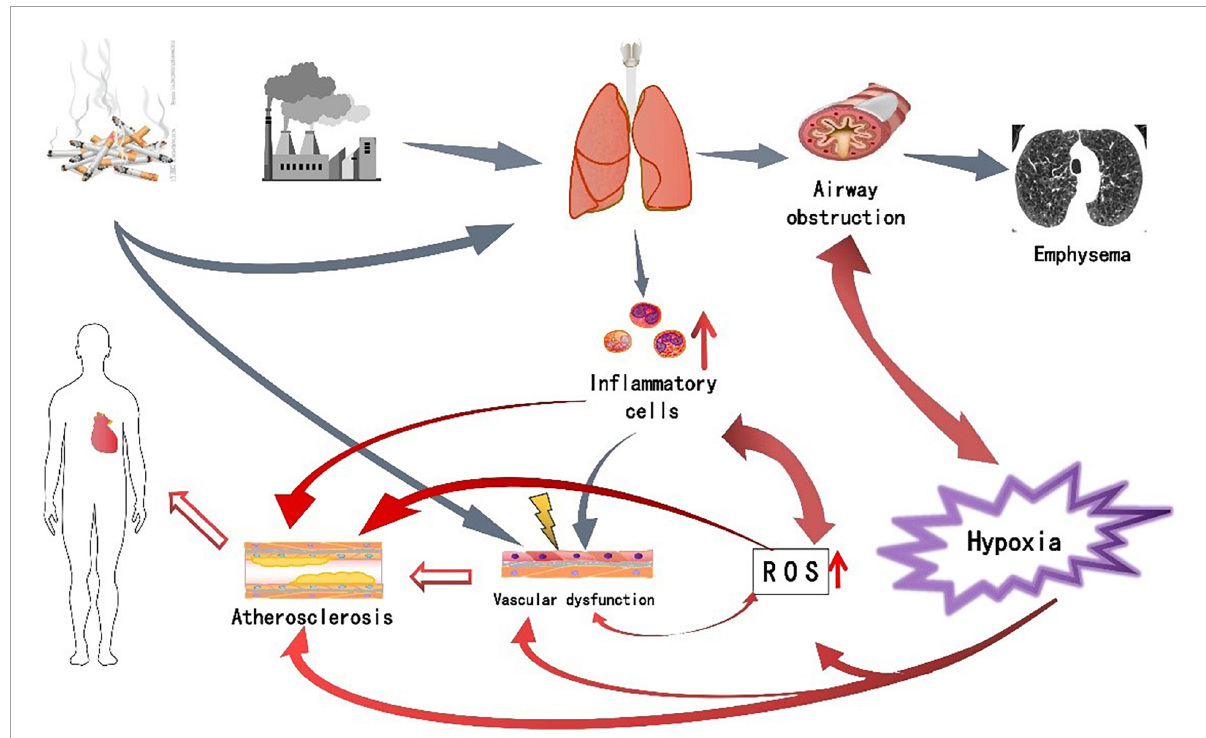
FIGURE1 The pathogenesis of chronic obstructive pulmonary disease (COPD) complicated with cardiovascular disease (CVD) and the relationship between various